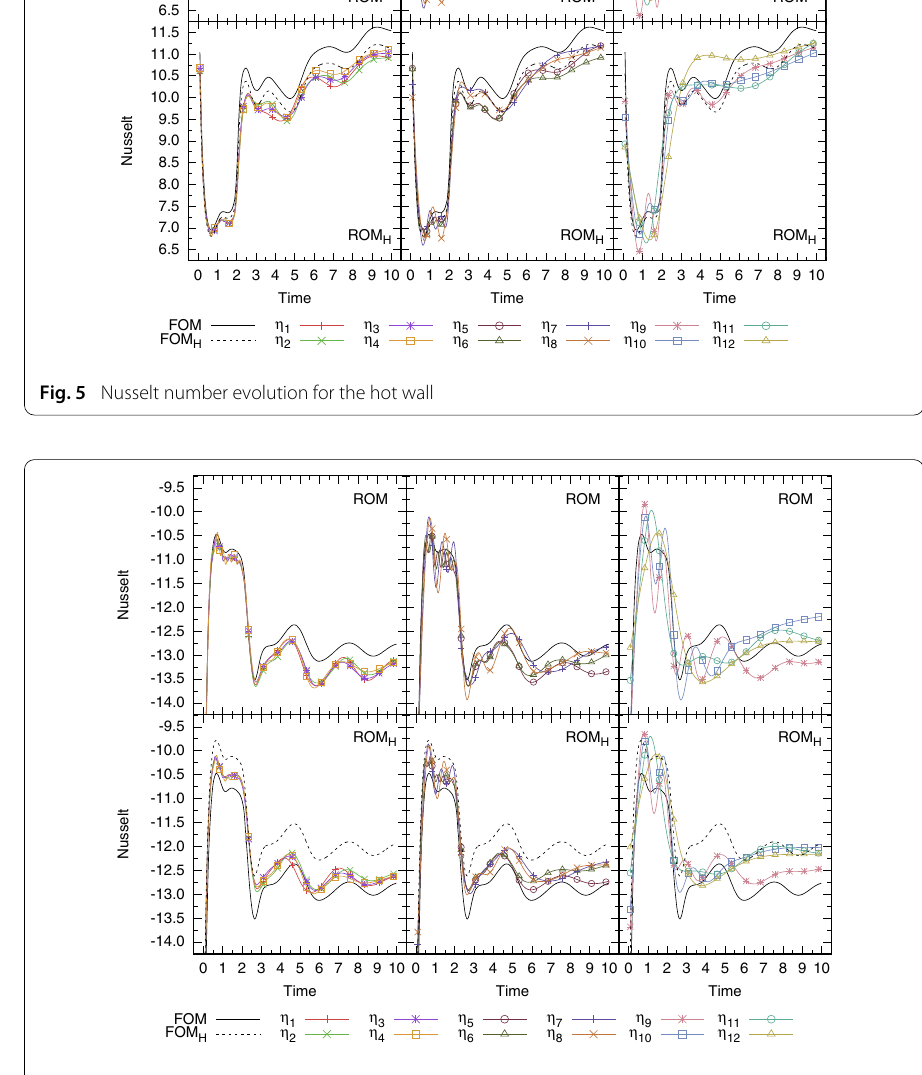
Fig. 6 Nusselt number evolution for the cold wall